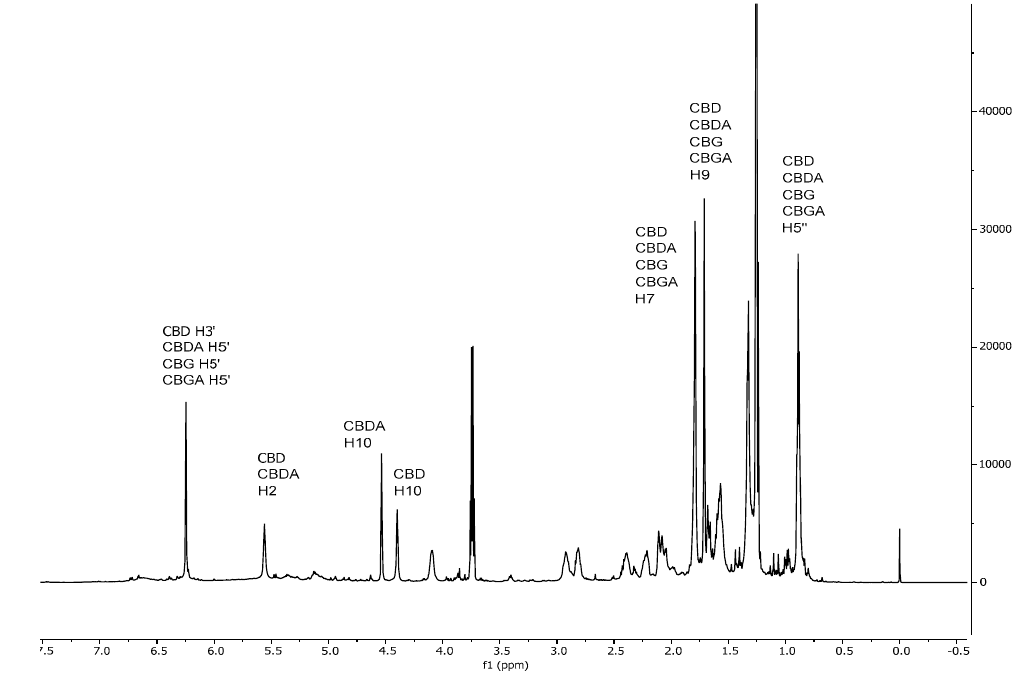
Figure 1. Typical 1 H spectrum of a hemp ethanolic extract.